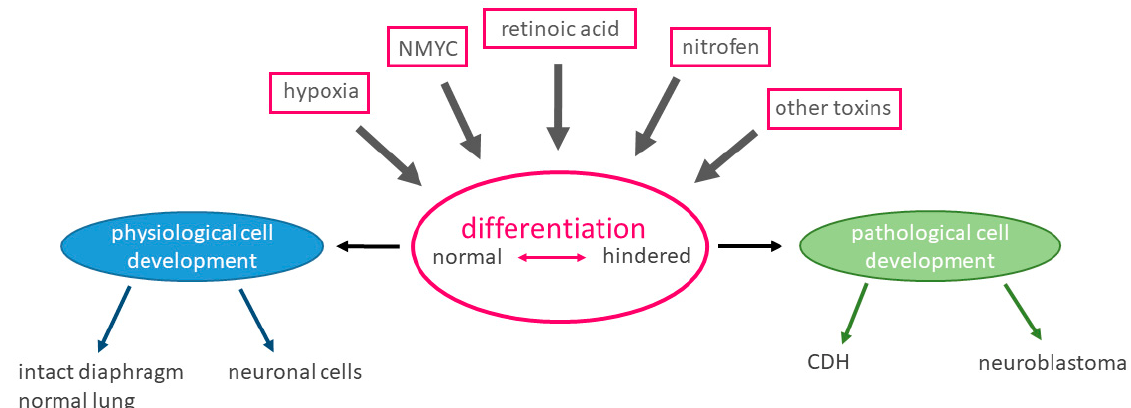
Figure 3. Schematic view of hypothesis: Possible influences on differentiation. The schematic view shows possible influences on physiological differentiation and development, including both possible pro-differentiation influences such as retinoic acid and NMYC as well as anti-differentiation influences such as nitrofen, other toxins and hypoxia. Timing and interaction of the physiologically occurring influences is essential in this developmental process. We hypothesize that a faulty differentiation at a specific time in development or recurring exposure to toxins can lead to the simultaneous occur- rence of both CDH (congenital diaphragmatic hernia) and neuroblastoma. They might even arise from the same cause.